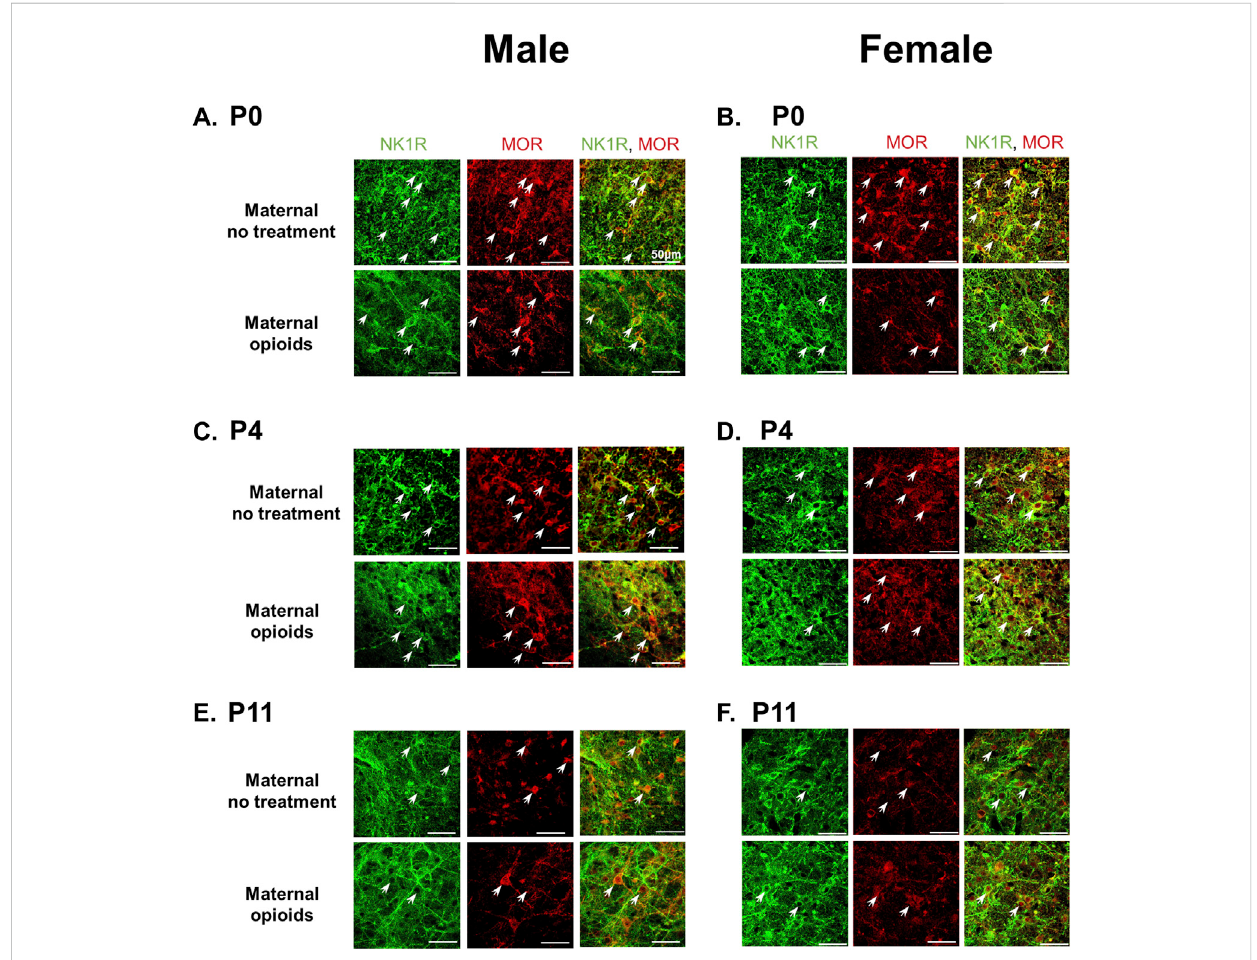
FIGURE 5 Mu-opioid receptor expression on preBötzinger Complex NK1R + neurons decreased in P0 neonates after maternal opioids, but not at P4 or P11. Representative confocal images (40x) show NK1R + preBötzinger Complex neurons (green) and mu-opioid receptors (red) colocalization (white arrows) decreasedinP0male (A) andfemale (B) neonatesaftermaternal opioidscomparedtoP0sex-matchedneonatesaftermaternalnotreatment.Mu-opioid receptorsweresimilarinP4male (C) andfemale (D) neonatesaftermaternalopioidsandP11male (E) andfemale (F) neonatesaftermaternalopioids compared to age- and sex-matched neonates after maternal no treatment ( n = 3 per treatment, age and sex; scale bars 50 μ